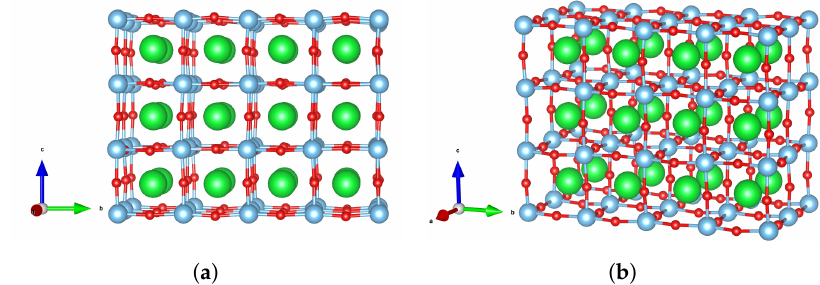
Figure 1. Flat surface cell. ( a ) Front view. ( b ) Isometric view.